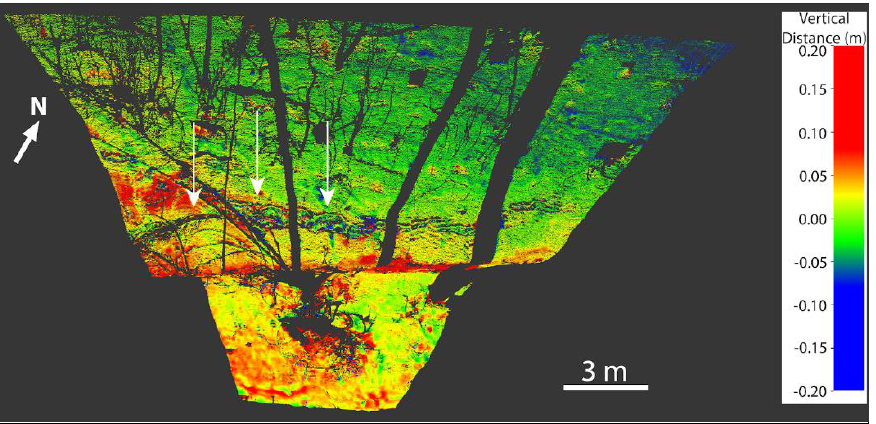
Figure 10. Differences between the August 2020 and the March 2021 TLS – derived point clouds from Kechries site one. The eastern crack that was visible in the UAV – derived DSM comparison (see also Figure 5) is partly non-visible due to the obstruction of the laser beam by the remaining tree logs.